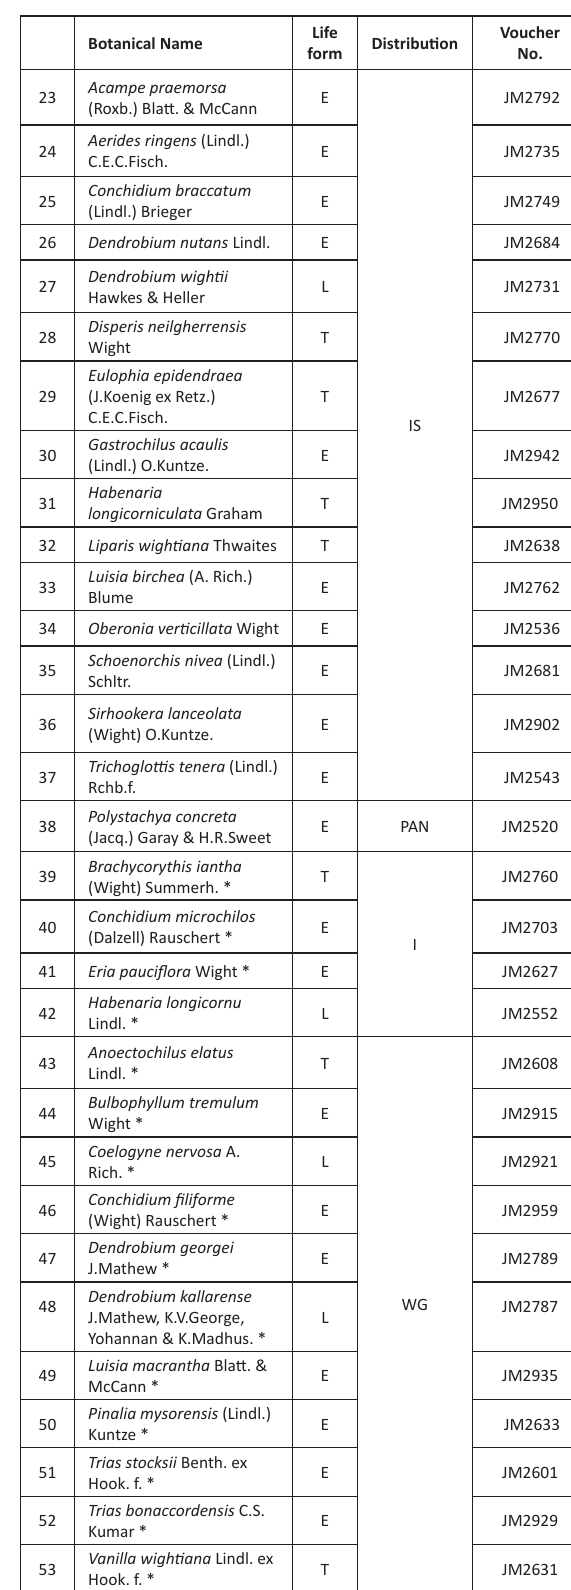
Table 1. An orchid checklist of the Kottavasal